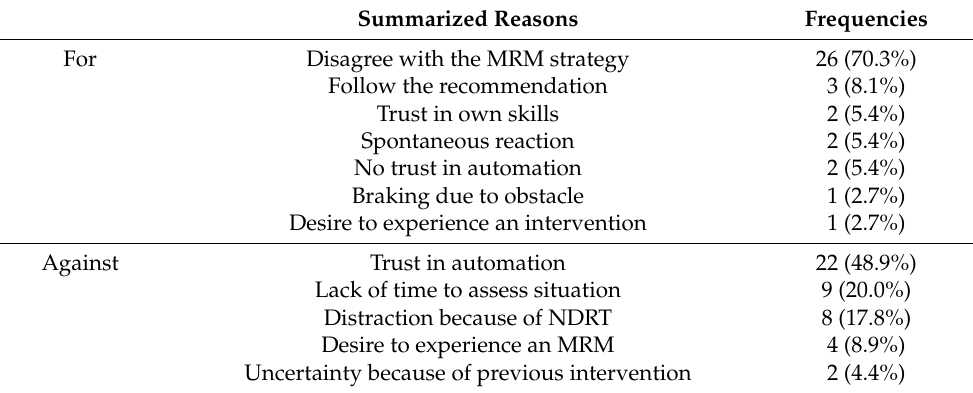
Table 5. Reasons for and against an intervention during the transition phase. Multiple answers were